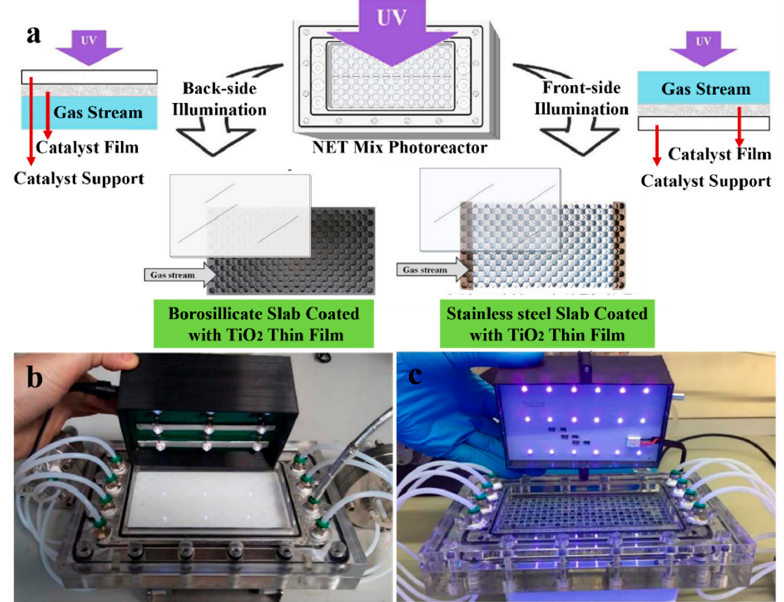
Figure 7. Schematic representation of back-side illumination or front-side illumination mecha- nisms ( a ). Photoreactor with LED 9 illumination system and LED 18 illumination system ( b , c ) [27]. Copyright 2019, Elsevier.